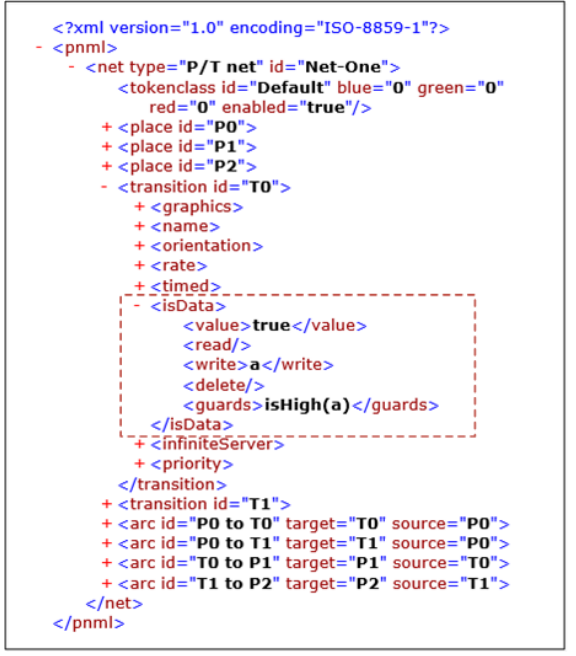
Figure 7. An extended PNML [53] (ePNML) document of Petri nets with data operations and guards. DICER 2.0 is developed-based on Platform Independent Petri Net Editor (PIPE) [40], which is an open source and graphical tool for drawing and analyzing Petri nets. In details, which includes some flow information, inheritance relations, interfaces and methods.